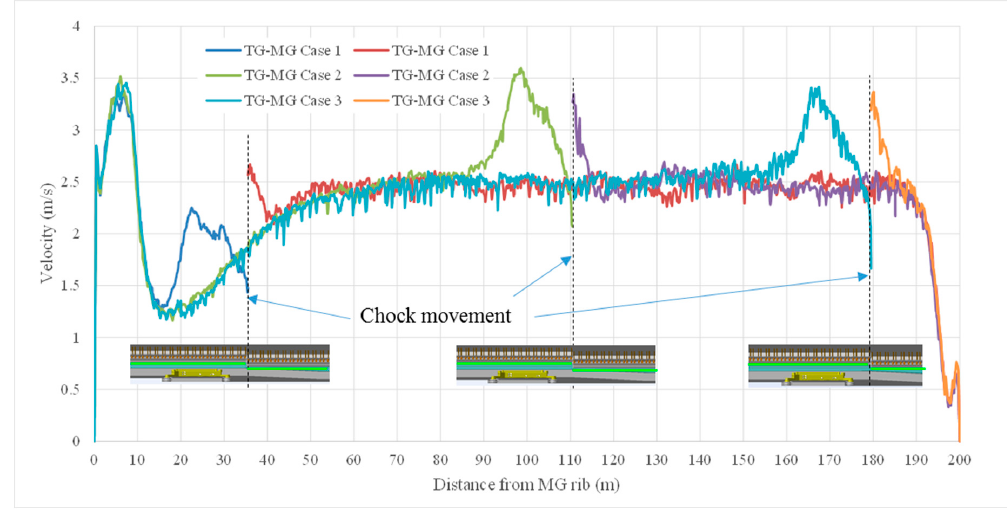
Figure 13. Velocity distribution along face for the TG-MG Cases.